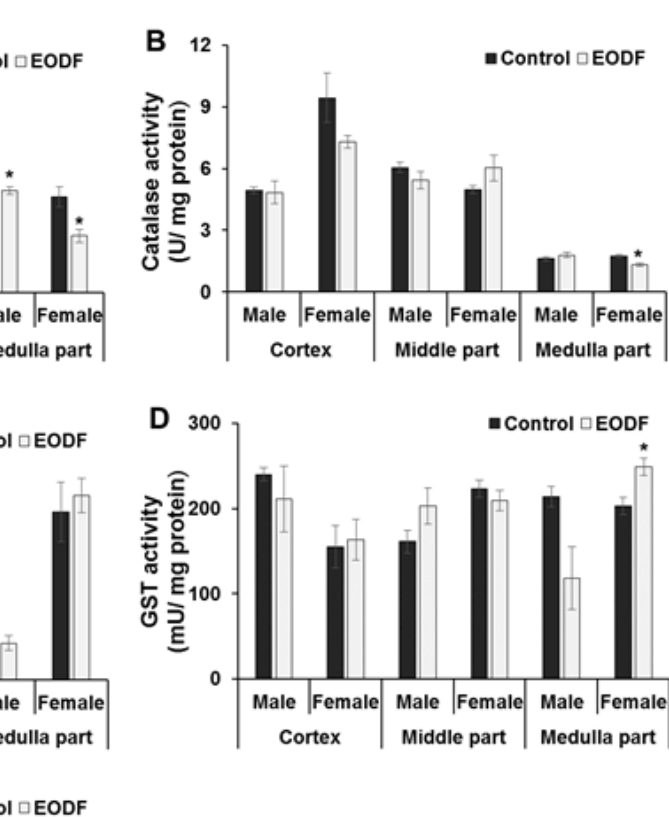
Figure 3: The effect of EODF on the activities of: ( A ) superoxide dismutase ( n = 3-6), ( B ) catalase ( n = 5-6), ( C ) glutathione peroxidase ( n = 4-6), ( D ) glutathione-S-transferase ( n = 4-6), and ( E ) glyoxalase 1 ( n = 5-6) in different parts of the brain of male and female young mice. Data are mean ± SEM. *Significantly different from the corresponding values for the ad libitum fed (control) group, P <